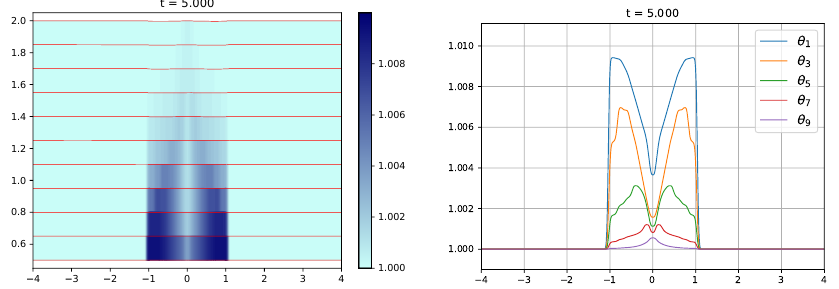
Figure 15. Evolution of the relative density at t = 5 s.